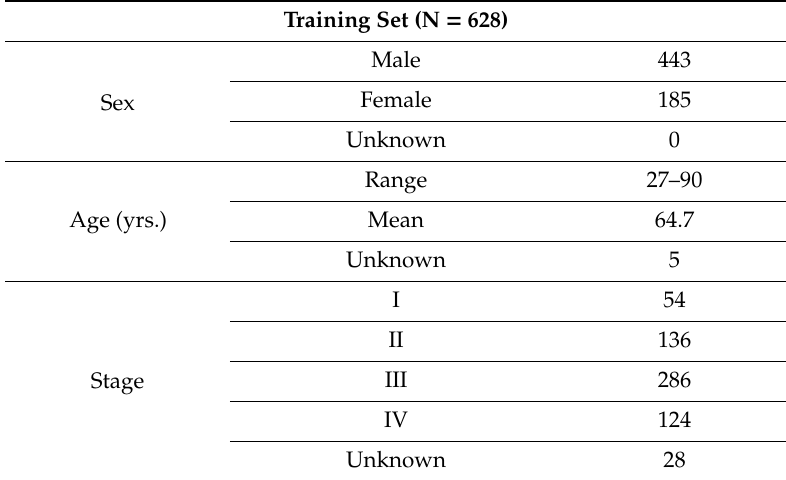
Table 1. The Cancer Genome Atlas (TCGA) training set clinical characteristics.